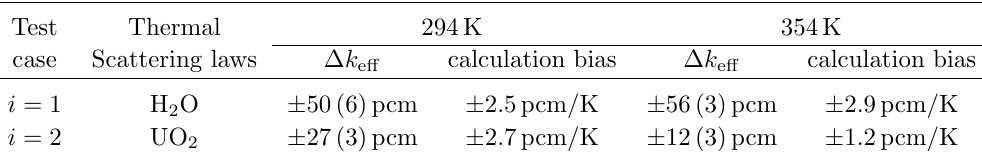
Table 4. k eff uncertainties obtained for the MISTRAL-1 core at 294 and 354 K due to the model parameter uncertain- ties reported in Table 2. This uncertainty indicator expressed in pcm/K represents a calculation bias on k eff relatively to the effective temperature uncertainty. The digits in parentheses come from the statistical uncertainty due to the Monte-Carlo calculations.